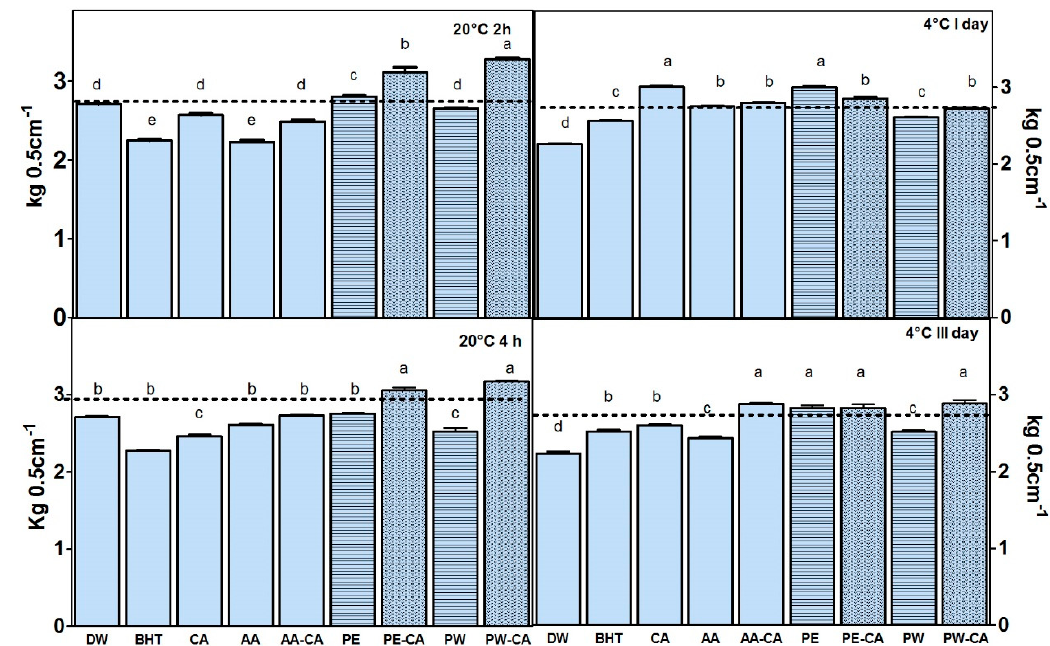
Figure 4. Flesh firmness expressed in kilogram-force (kg/0.5 cm 2 ) of fresh-cut apples treated with different preservative media (sample codes are described in Table 1). Data are referred to storage at 20 ± 1 °C (2 and 4 h) and 4 ± 1 °C (1 and 3 days). Values are means ± SE and different letters indicate significant statistical difference ( p ≤ 0.05).